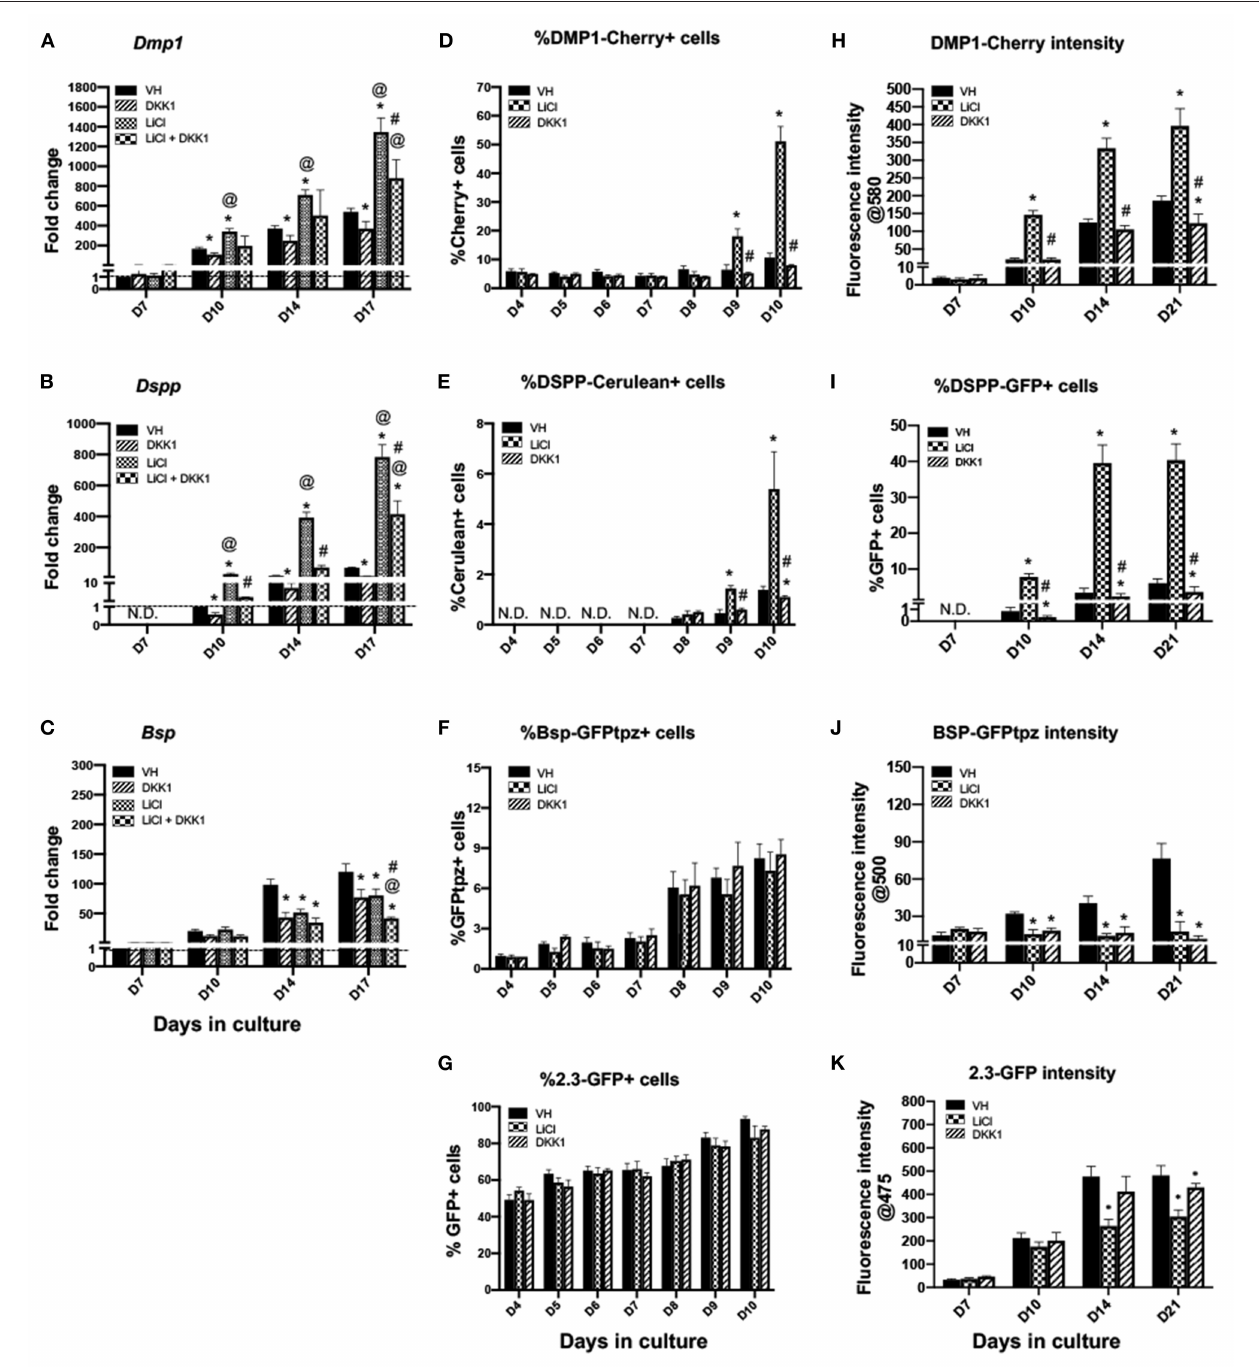
FIGURE 3 | Effects of continuous exposure to LiCl on the expression of differentiation markers and tissue- and stage-specific reporters in primary dental pulp cultures. Primary pulp cultures were treated continuously from days 3 to 21 with VH (0.1% BSA), DKK1 (50ng/ml), LiCl (10mM) or simultaneous LiCl (10mM) and DKK1 (50ng/ml). (A–C) Graphs showing changes in the expression of Dmp1 (A) , Dspp (B) and Bsp (C) in cultures treated continuously with VH, LiCl, and DKK1 alone or with simultaneous LiCl from days 3 to 17. Continuous exposure to LiCl showed significant increases in Dmp1 (A) and Dspp (B) at days 10–17, which were significantly decreased by DKK1 treatment alone. DKK1 treatment decreased the LiCl-induced increases in Dmp1 and Dspp . However, continuous LiCl treatment, as well as DKK1 treatment decreased Bsp expression. The LiCl-induced decreases were not reversed by DKK1 (C) . Expression of Dmp1 and Bsp was normalized to day 7 and Dspp was normalized to day 10 of the VH-treated cultures, which is arbitrarily set to 1 and is indicated by the dashed line. (D–G) Graphs showing the changes in the percentage of cells expressing DMP1-Cherry (D) , DSPP-Cerulean (E) , BSP-GFPtpz (F) , and 2.3-GFP (G) transgenes by FACS analysis between days 4 and